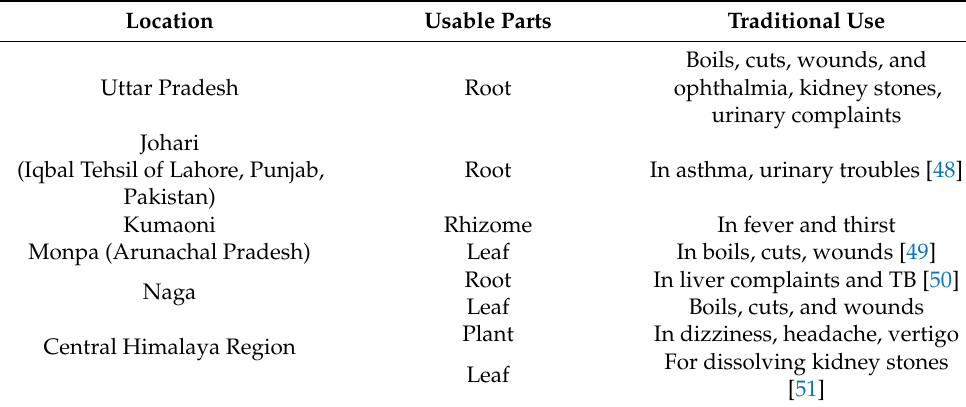
Table 3. Traditional uses of Bergenia pacumbis (Buch.-Ham. ex D.Don) C.Y.Wu & J.T.Pan in different region [21].